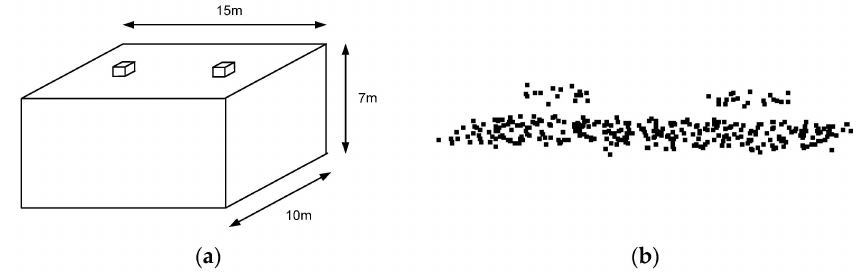
Figure 12. ( a ) Shape of a structure on which laser points are projected; and ( b ) the produced laser points on the rooftop of the